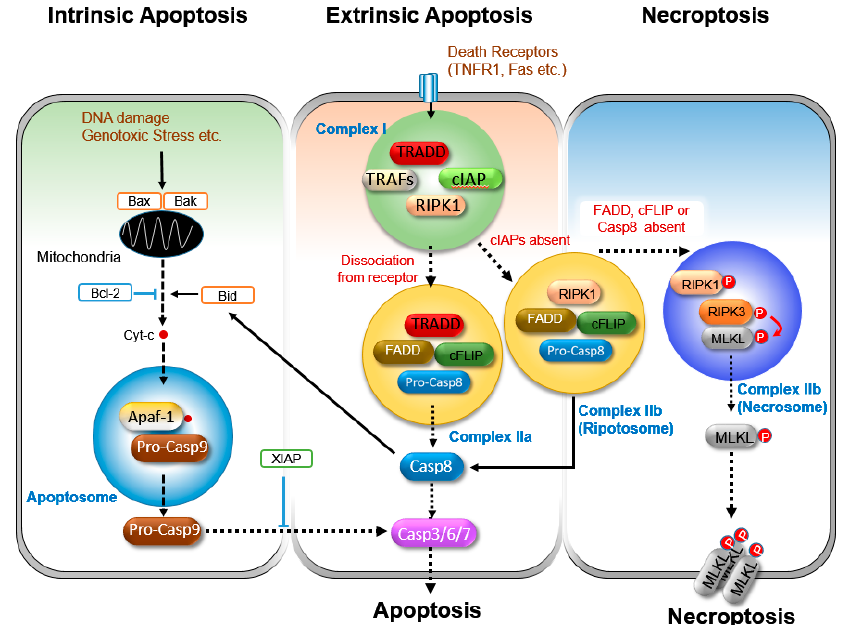
Figure 2. A simple depiction of the pathways for intrinsic and extrinsic apoptosis and